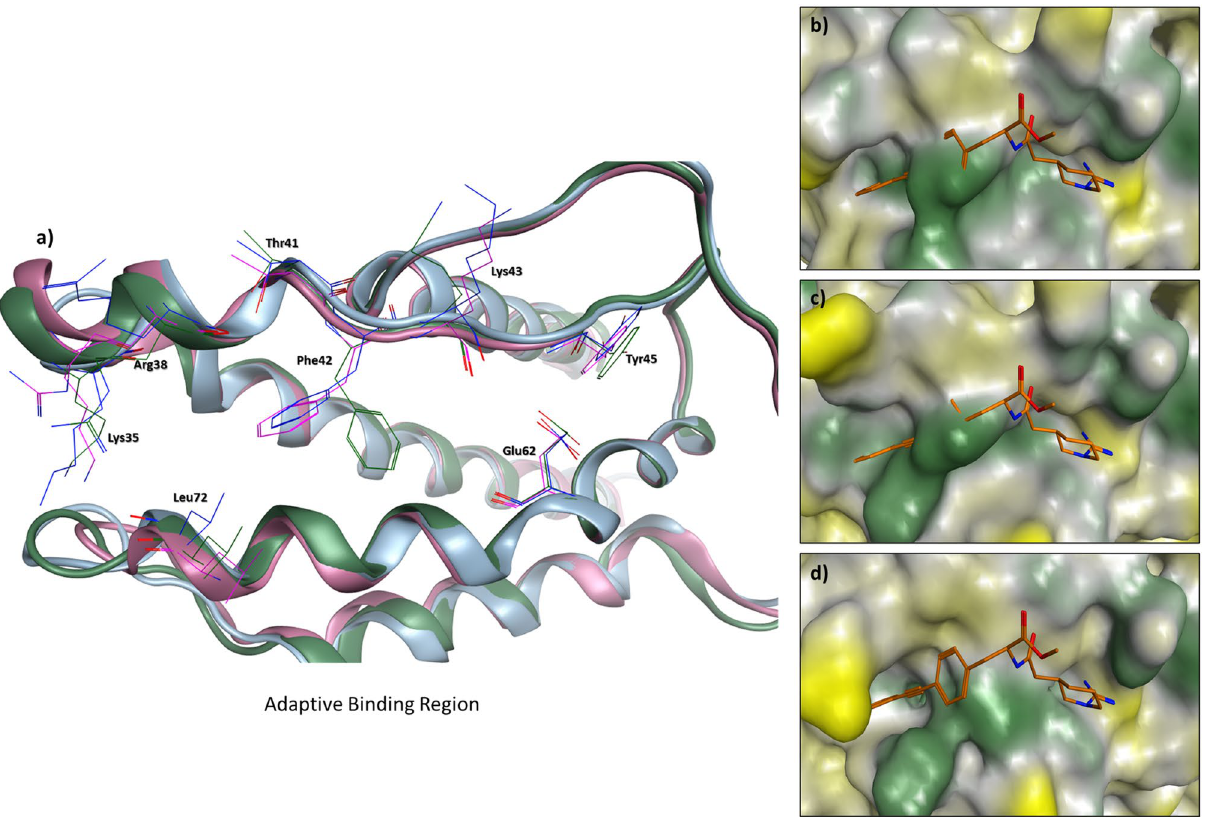
Figure 7. The protein binding interface of three IL-2 crystal structures aligned on each other. ( a ) Structural representation of the adaptive binding region at protein Interleukin 2 (IL-2) binding site. Apo structure is shown as pink ribbons, the peptide-bound structure as blue ribbons and the ligand-bound structure as green ribbons. It is evident that ( b ) the IL-2 apo form (PDB: 1M47 43 ) and ( c ) the protein-bound form (PDB: 2ERJ 44 ) completely lack the targeted binding cavity when compared to ( d ) the ligand-bound form (PDB: 1M48 43 ). The co-crystallized IL-2 inhibitor, (R)- N -[2-[1-(Aminoiminomethyl)-3-piperidinyl]-1-oxoethyl]-4-(phenylethynyl)- l-phenylalanine methyl ester (orange sticks), was aligned on the apo and protein bound structures to emphasize the change happening in the topology of the IL-2 interface. Surface color generated using MOE Pocket coloring: Green = hydrophobic, Yellow = hydrophilic, and Grey =